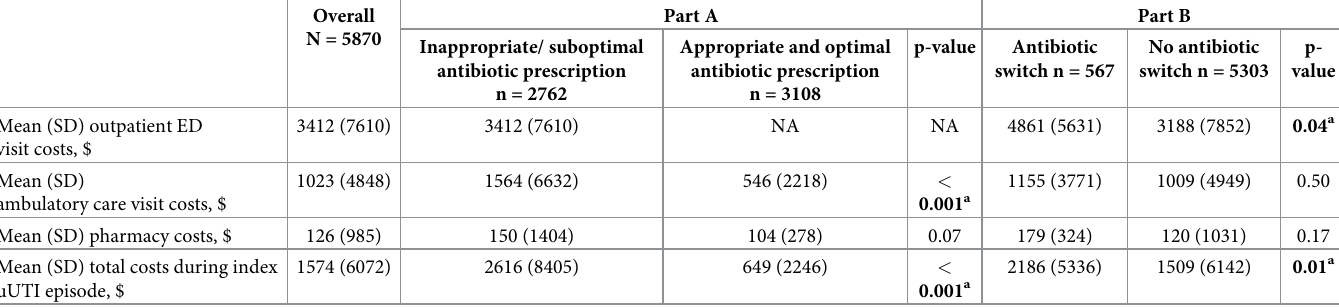
Table 4. Primary UTI-related cost outcomes of uUTI outpatients stratified by inappropriate/suboptimal antibiotic prescription (Part A) and antibiotic switching (Part B) during the index